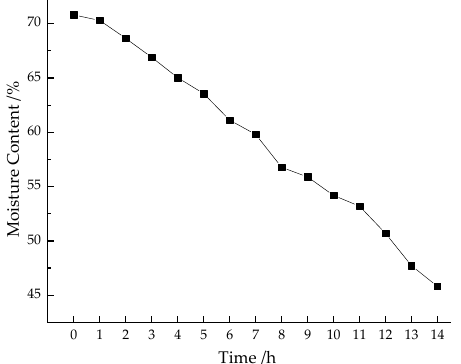
Figure 1. The moisture content of tea leaves changes with withering for 15 h.